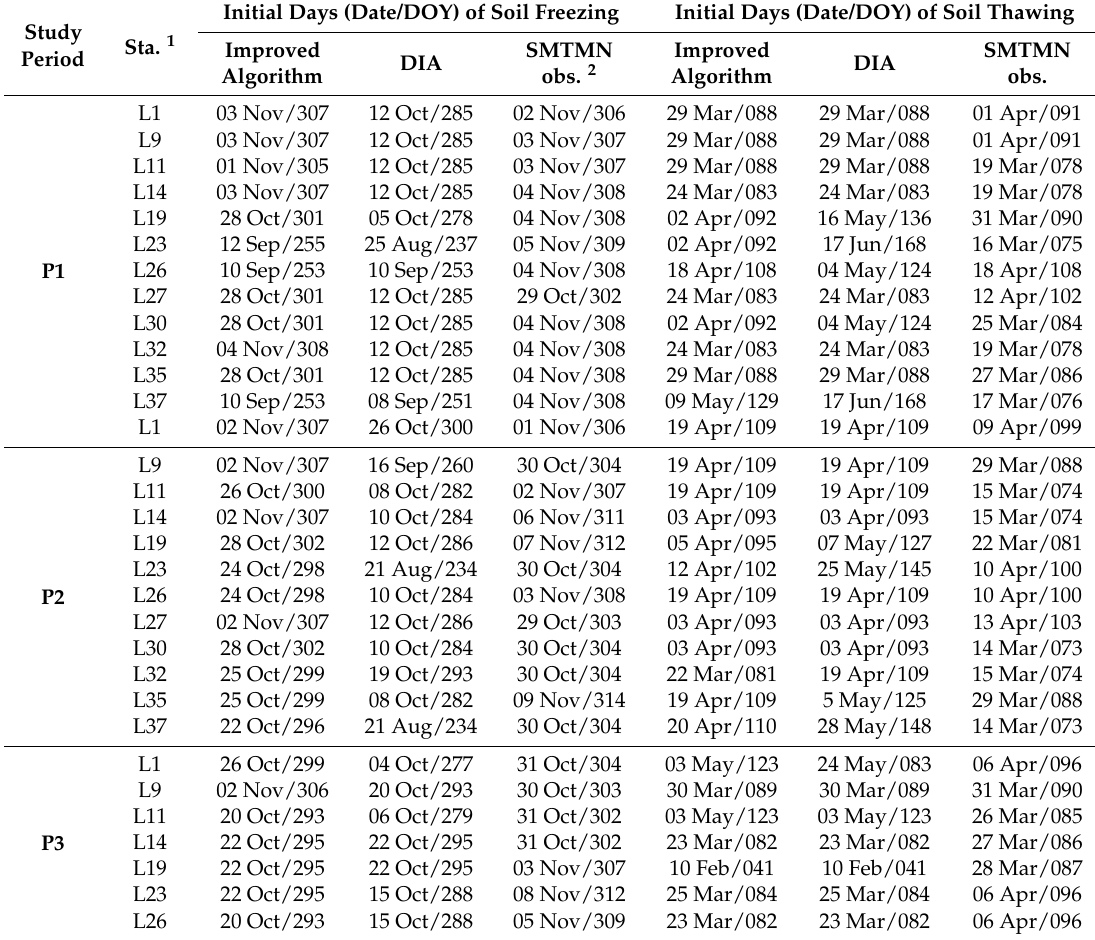
Table 2. Initial days of soil freezing and thawing at 12